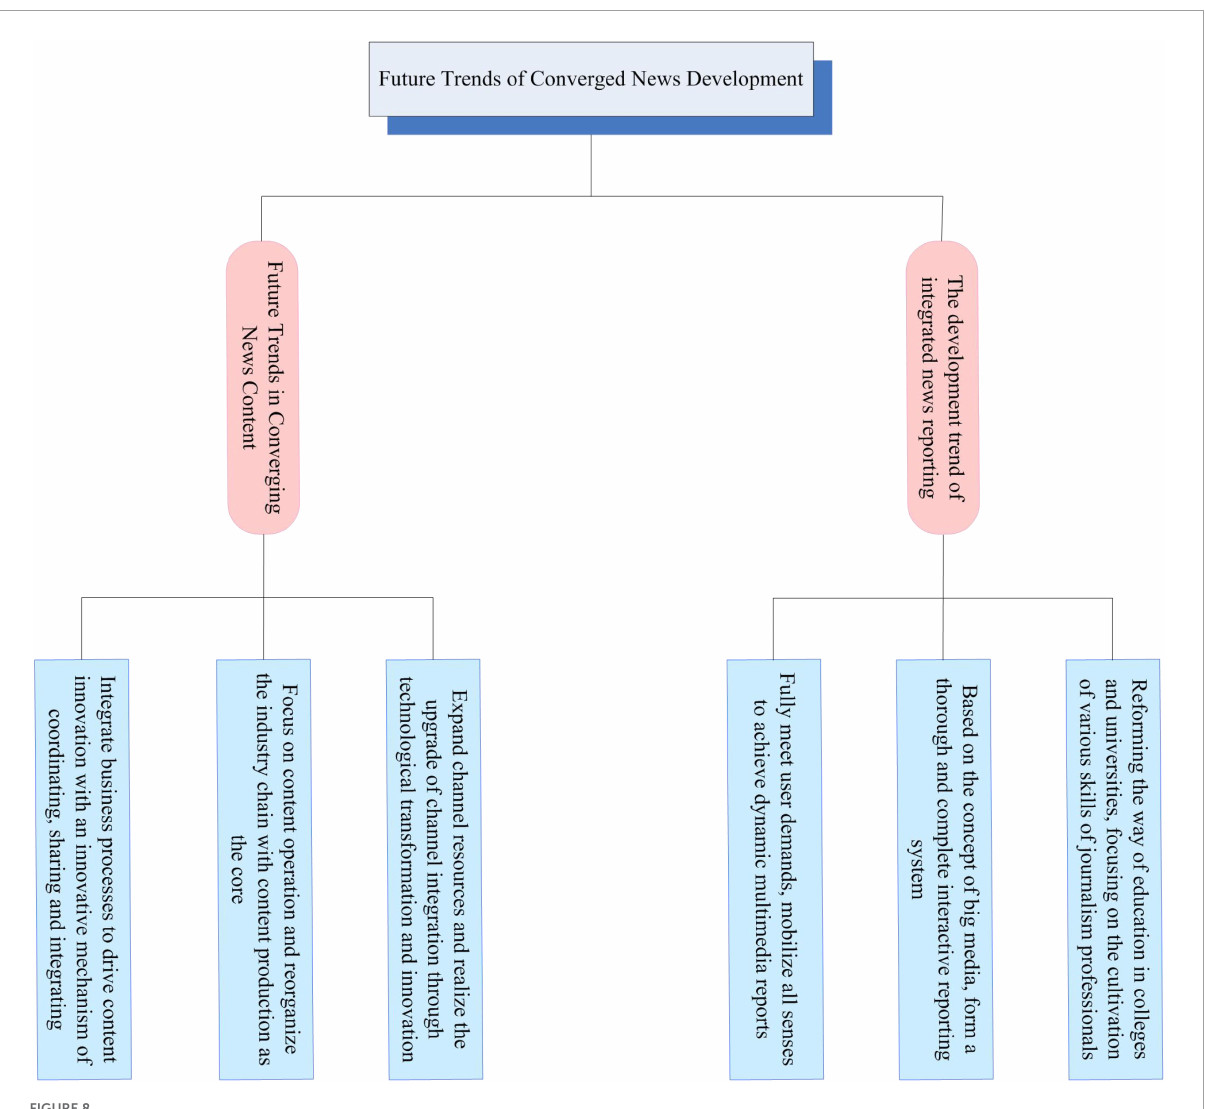
FIGURE8 Future trends in convergent news